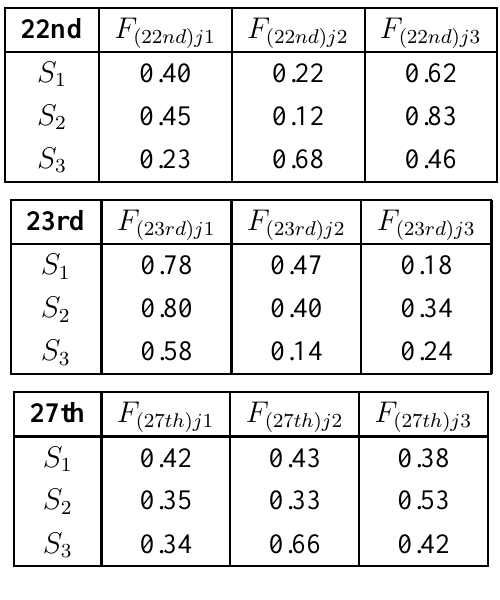
Table 7. Three features of three observation points ( 𝑆 (the 22nd, 23rd, and 27th).